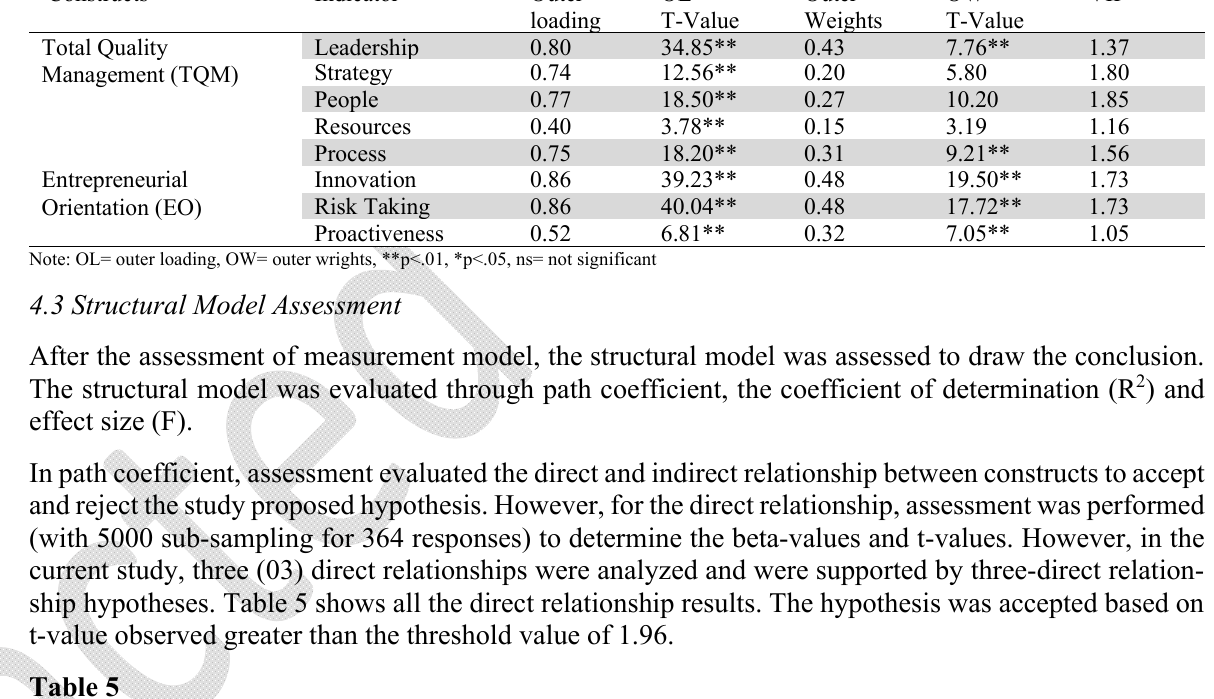
Findings of structural model (Direct effect results) Beta Standard